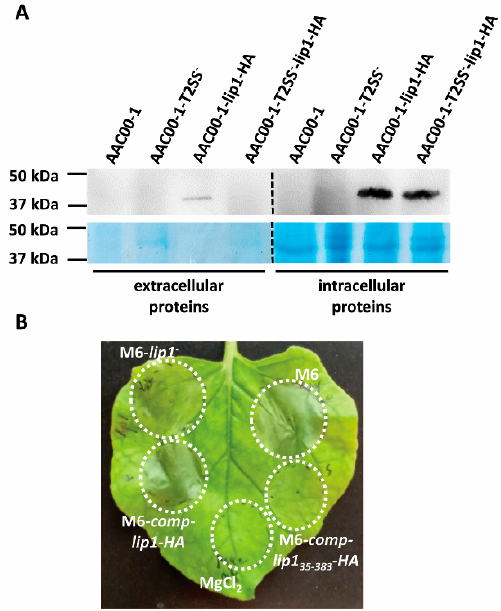
Figure 8. Type II secretion (T2S) of Lip1. ( A ) Western blot analysis of extracellular and intracellular fractions of A. citrulli strains (AAC00-1, wild-type; AAC00-1-T2SS - , T2S mutant) expressing or not recombinant Lip1-HA (see details in Materials and Methods). Representative images of one out of two experiments with similar results are shown. Dashed lines between extracellular and intracellular proteins indicate that the images were composed for comprehensive visualization of treatments. The original images are shown in Figure S4. ( B ) Infiltration of four-week-old N. benthamiana